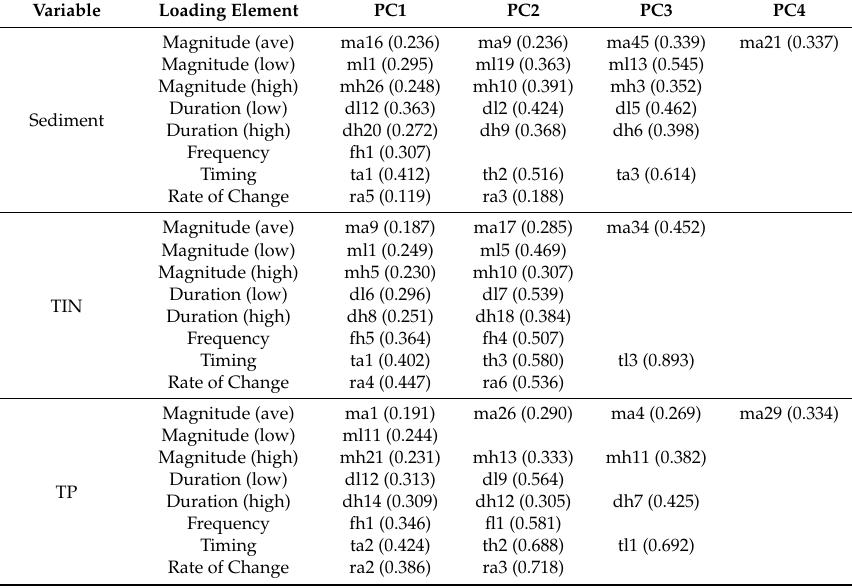
Table 4. Indices with greatest absolute loadings of each principal component axis (PC1–PC4) represent each major element of a loading regime in Hinkson Creek, Missouri, USA. Average is ‘ave’. Definitions of indices are located in Table 5. Total inorganic nitrogen is TIN, and total phosphorus is